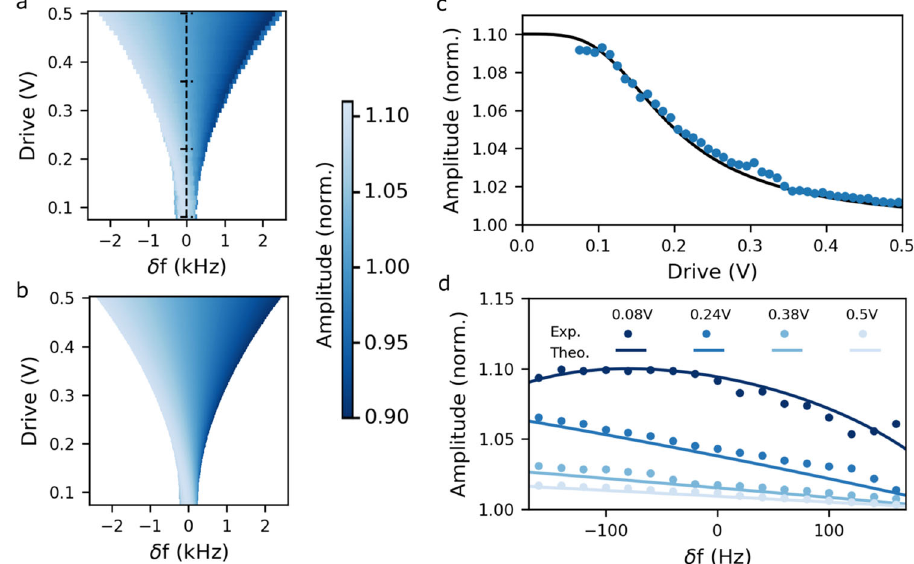
Fig. 3 Amplitude variation within the synchronization range. As the drive F osc is changed, the ratio between the perturbation and the drive F e = F osc is kept at a constant level of 10%. The amplitude is normalized to that of the free-running oscillator for the same drive ( X = X frequency detuning leads to an amplitude variation ( a : experimental results, b : model). c Cross-section of panel ( a , b ) along δ f ¼ 0, where the amplitude drops towards the free-running oscillator amplitude as the nonlinearity increases (line: theory, dots: experiment). d Cross-sections of panels ( a , b ) along different drive levels near zero detuning, where the amplitude variation changes from parabolic to linear with a decreasing slope. Measurement errors mainly arise from frequency drifts on the order of 20 Hz, close to the distance between two consecutive